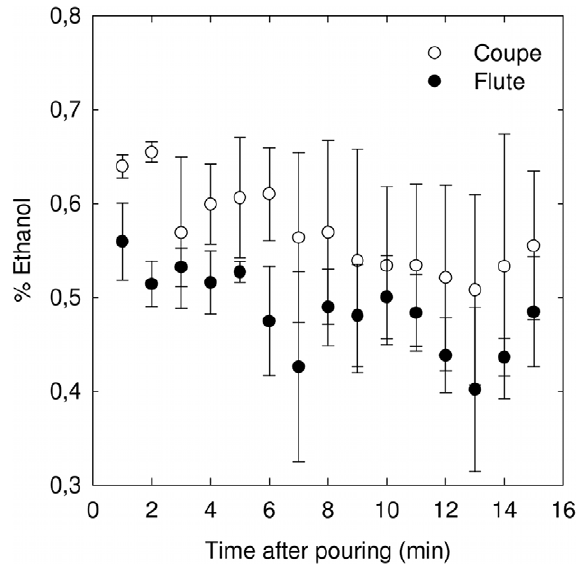
Figure 6. Monitoring ethanol concentrations in the headspace of a flute or a coupe filled with champagne. Ethanol concentra- tions found in the headspace above the champagne surface, all along the first 15 min after pouring champagne (for a bottle stored at 20 u C), depending on whether champagne is served into the flute or into the coupe; each datum of each time series is the arithmetic average of six successive values recorded from six successive pouring; standard deviations correspond to the root-mean-square deviations of the values provided by the six successive data recordings.